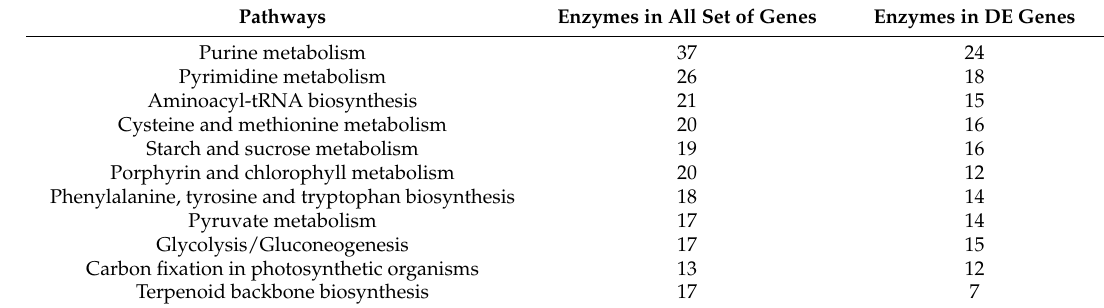
Table 4. Summary of KEGG pathways ranked by the number of associated enzymes, detected in predicted genes and in DE